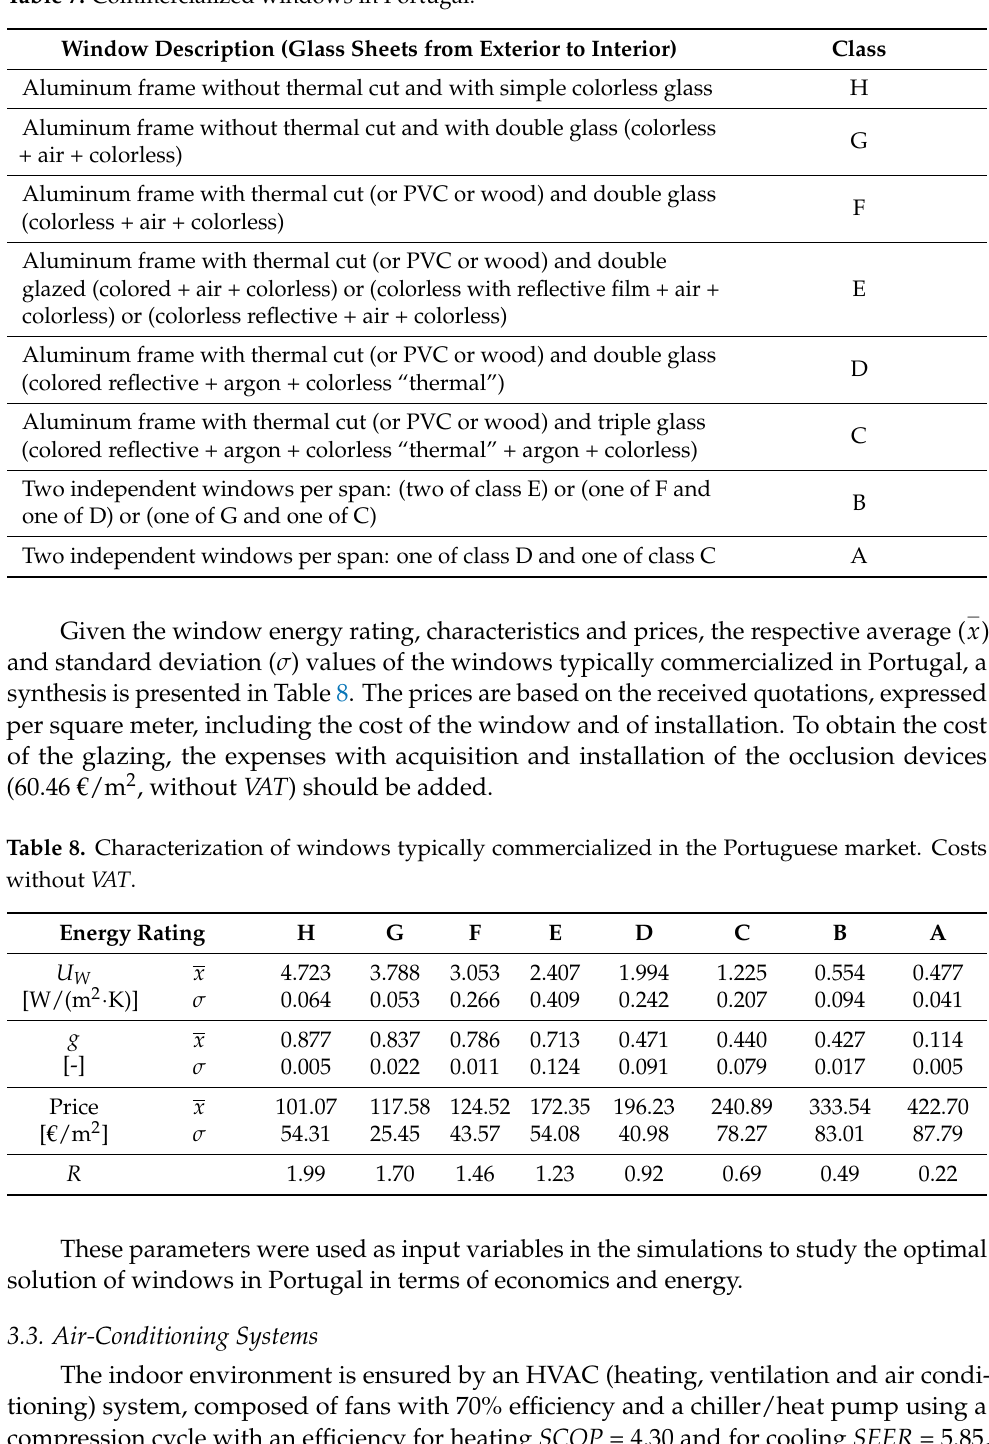
Table 7. Commercialized windows in Portugal.